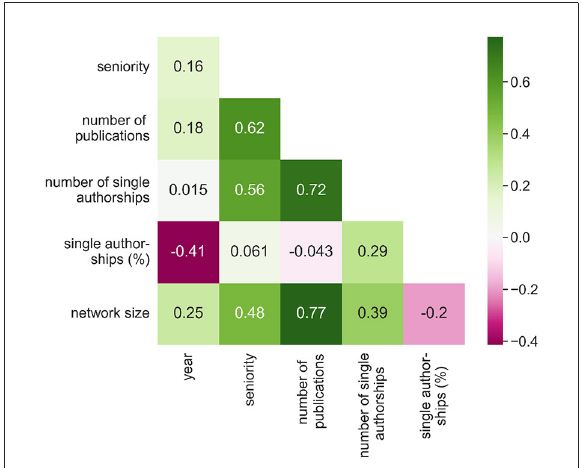
FIGURE1 Pairwise Pearson correlation coefficients between numerical input variables and target variables. For better understanding, we include the percentage of single authorships among all authorships of an author. All relationships are statistically significant with p -value